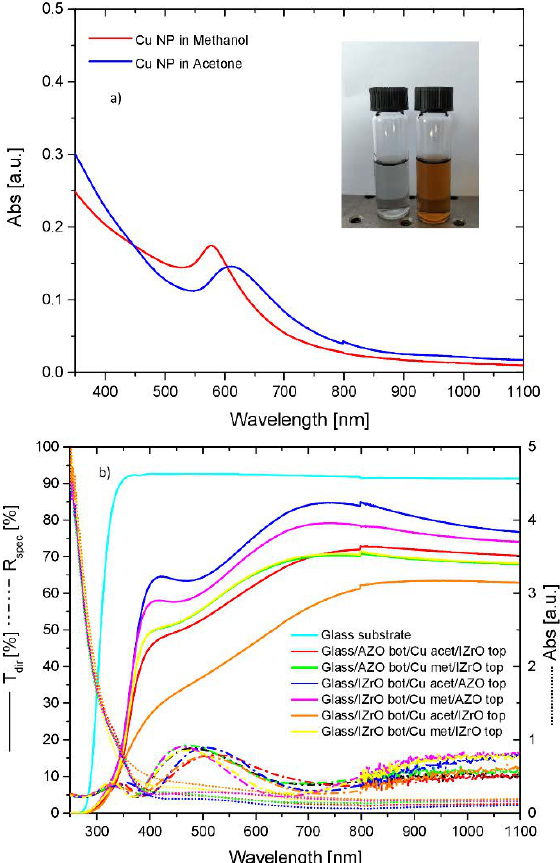
Figure 5. ( a ) Absorbance spectra of colloid solutions of metallic copper nanoparticles prepared